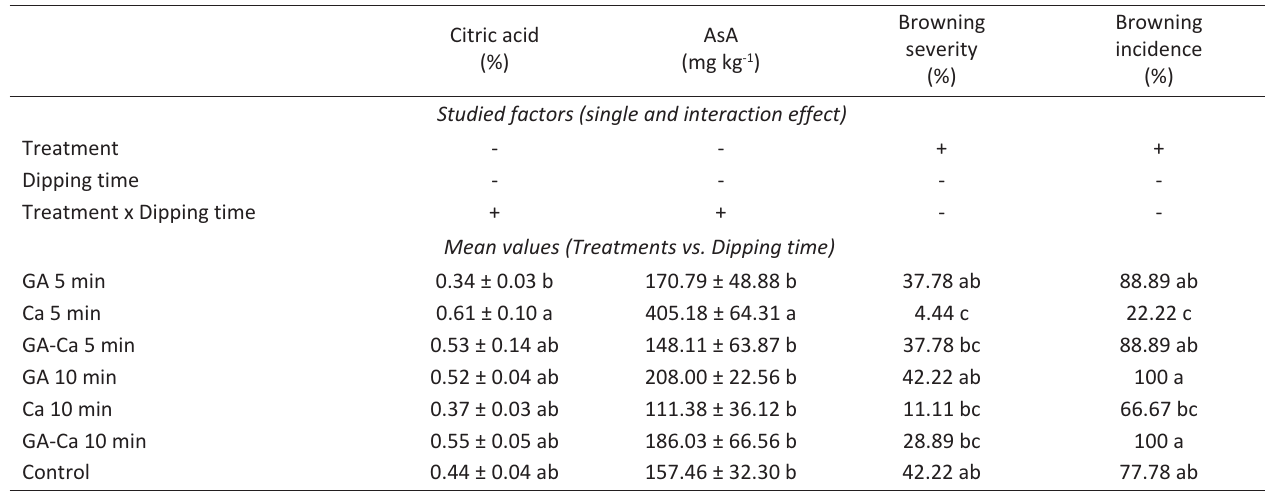
* Results marked with (+) indicate that the P­value (p < 0.05) for the single or interaction can be considered to draw conclusions; mea­ nwhile, results marked with (­) indicate that the P­value (p>0.05) for the single or interaction are not significant to draw conclusion in the text. Mean values ± SE in each column followed by the same lower­case letters are not statistically different by Duncan’s multiple range test, and Kruskal­Wallis test (for the internal browning data) (p<0.05). Treatments: GA, Ca, mix GA­Ca, Control ­ no use of GA and Ca. Dipping time: 5 and 10